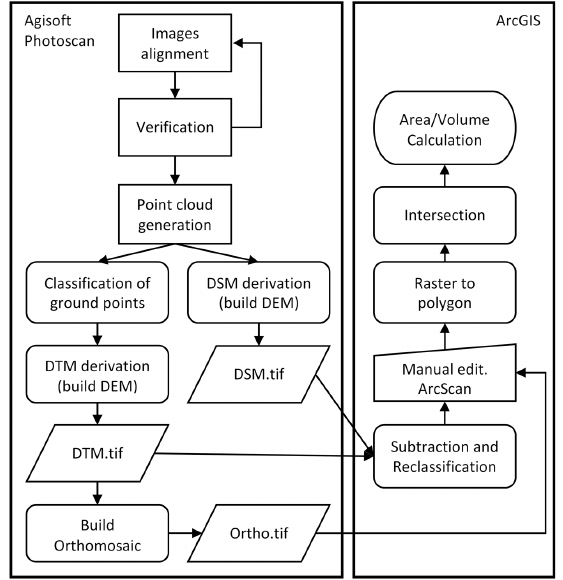
Figure 2. The workflow diagram of the imagery data processing to the final area and volume estimation conducted within the Agisoft Photoscan software [37] and ArcGIS 10.2 software [34].